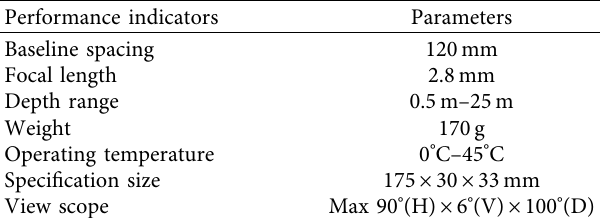
Table 1: Main parameters of ZED